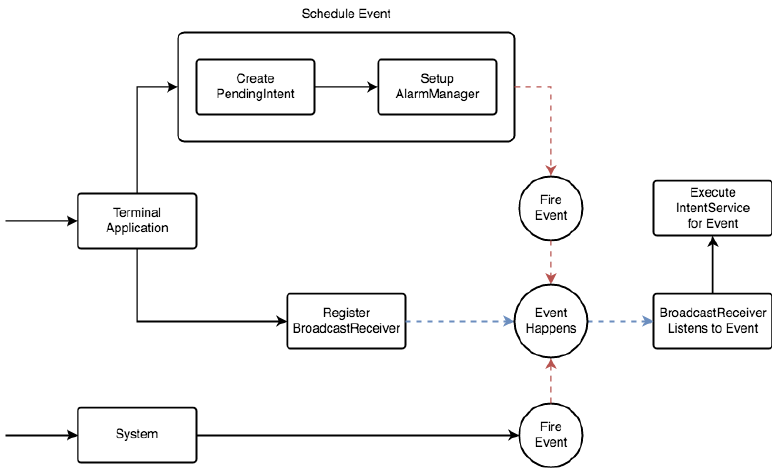
Figure 5. Device agent—creating, listening, and handling